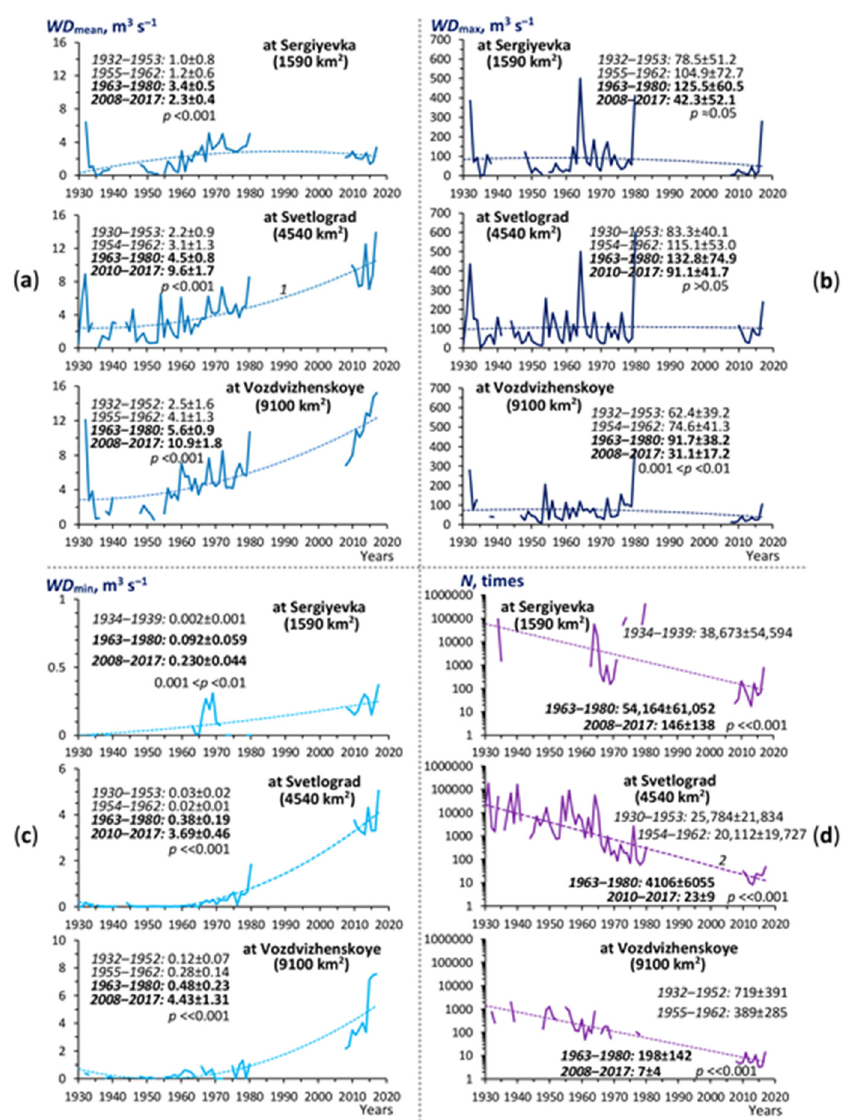
Figure 4. Contemporary long-term changes in Kalaus River’s water discharge at the analyzed hydrological stations (see Figure 1; Table 1). WD mean —mean annual water discharge ( a ); WD max —maximal (per annum) water discharge ( b ); WD min —minimal (per annum) water discharge ( c ); N —